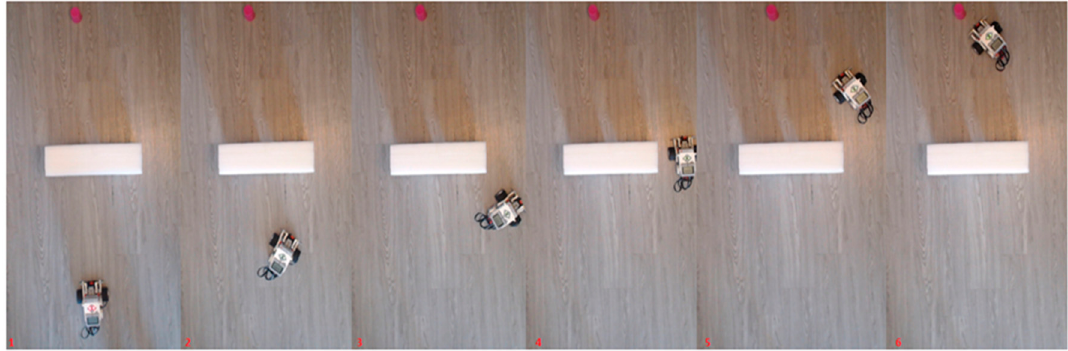
Figure 14. Experimental setup; 1. Scenario—robot motion control from start (1) and goal (6) position.